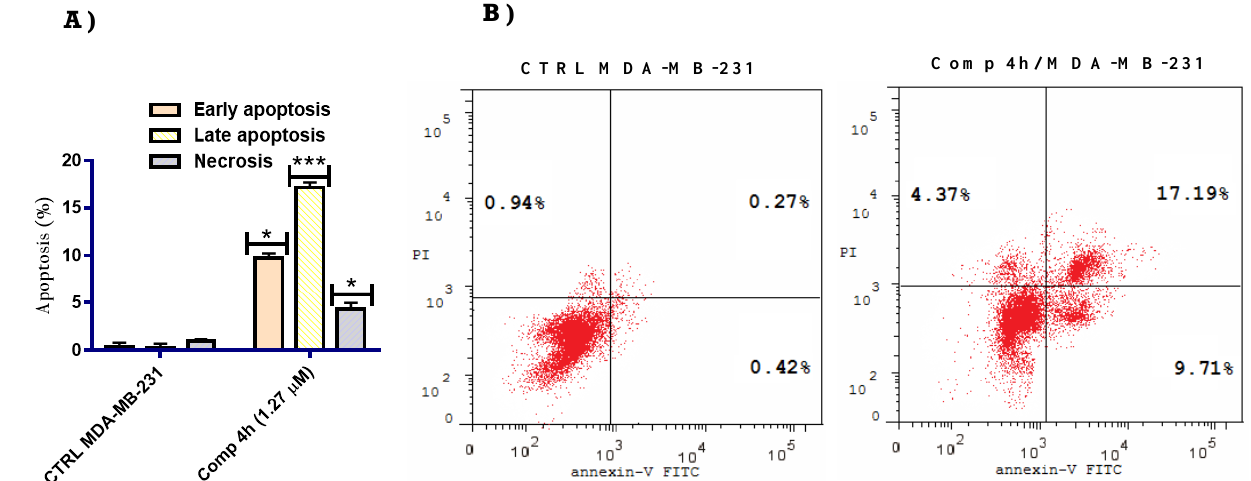
9 of 29 Figure 4. (A) Graphical representation for the effect of Schiff base 4h on the cell cycle profile of MDA-MB-231 cells after 24 h. ( B) Effect of Schiff base 4h on the cell cycle profile of MDA-MB-231 cells after 24 h. All values are presented as mean value ± SD and statistical analyses were carried out using one-way analysis of variance (ANOVA) followed by Tukey’s multiple comparison test (* p < 0.05, *** p < 0.001). 2.2.4. Apoptosis Inducing Effect of Compound 4h A double staining examination of annexin V FITC/propidium iodide (PI) was used to evaluate compound 4h ’s influence on apoptosis and estimate the percentage of the total, early, and late apoptosis in MDA-MB-231 cells. Compound 4h treatment resulted in a higher proportion of overall apoptosis in the MDA-MB-231 cell line (31.27%) as compared to no treatment controls (1.63%). Furthermore, the proportion of early and late